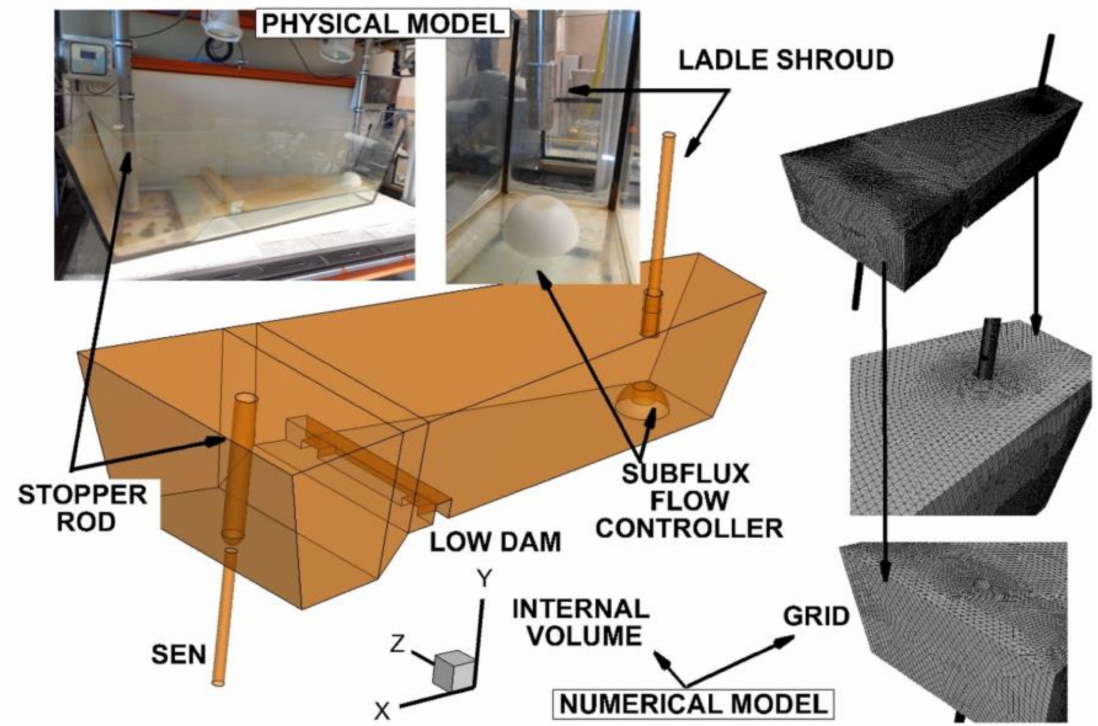
Figure 1. Numerical and physical model of tundish with subflux flow